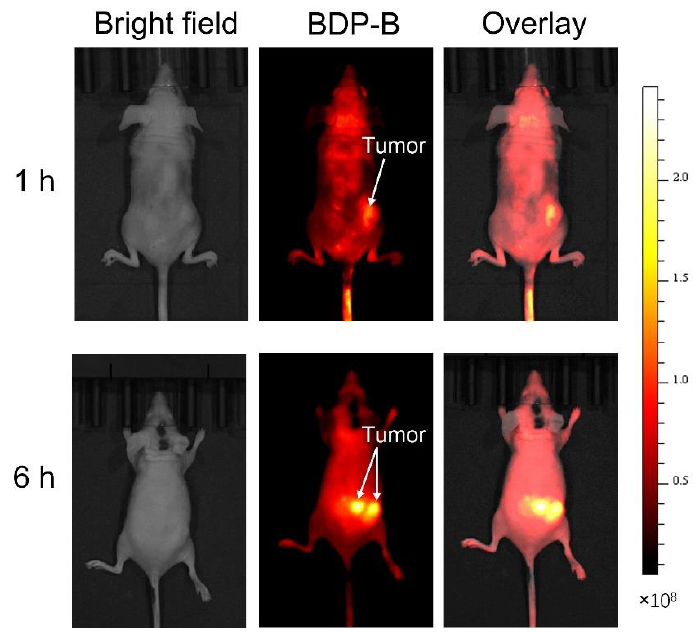
Figure 4. In vivo tumor imaging at 1 and 6 h after caudal intravenous injection of BDP-B NPs.